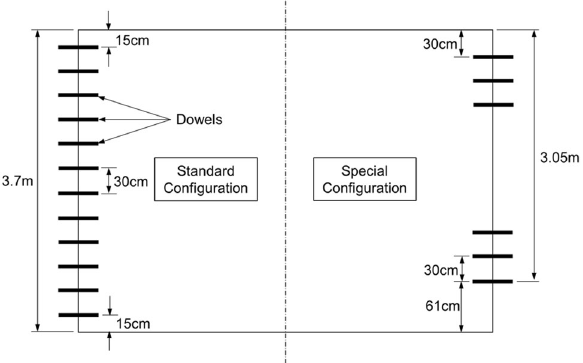
Fig. 3 Schematic layouts for project sections with different dowel arrangement.